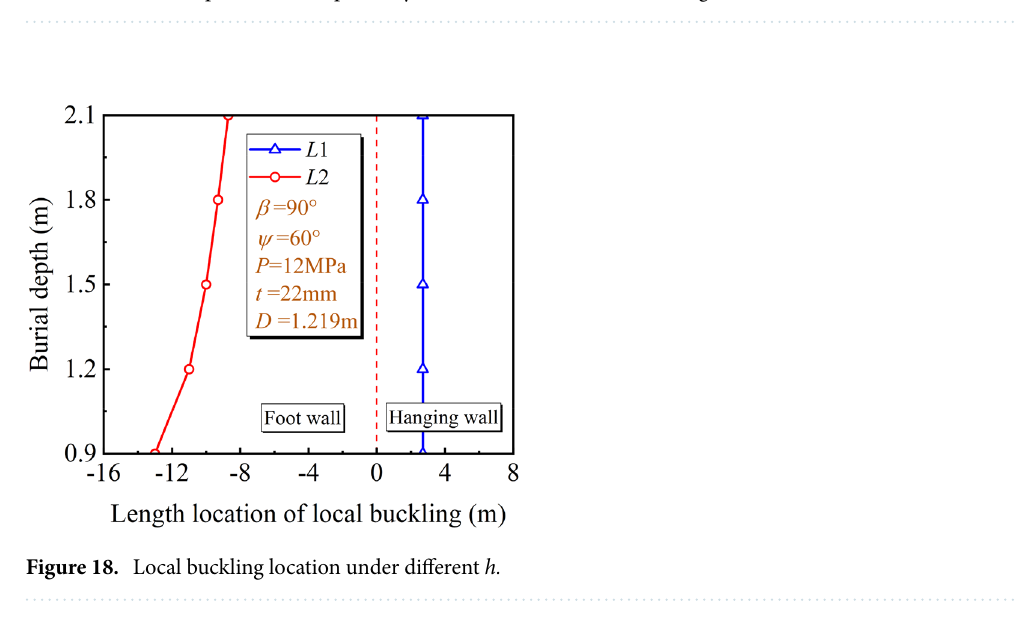
Table 4. δ crit under different fault types and D / t. a ( b ) [ c ]. a , b , c are δ crit under the oblique-reverse, strike-slip and reverse fault displacement, respectively. OCR out of the considered range.